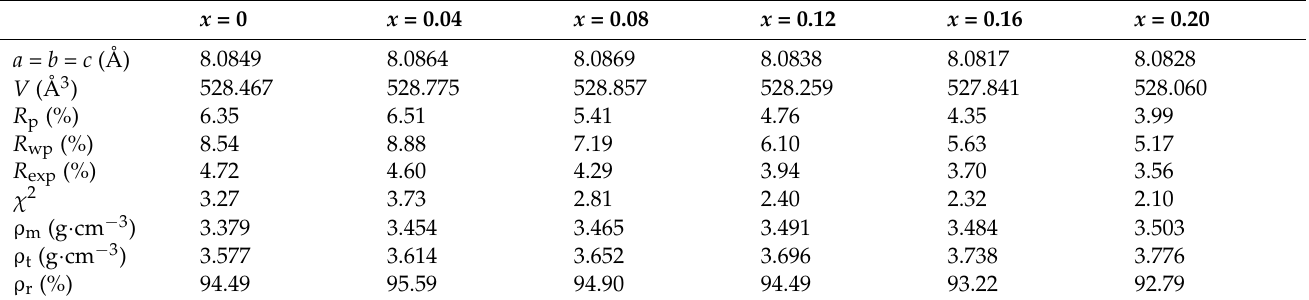
Note: The ρ m , ρ t , and ρ r are the measured density, the measured density, and the relative density, respectively.